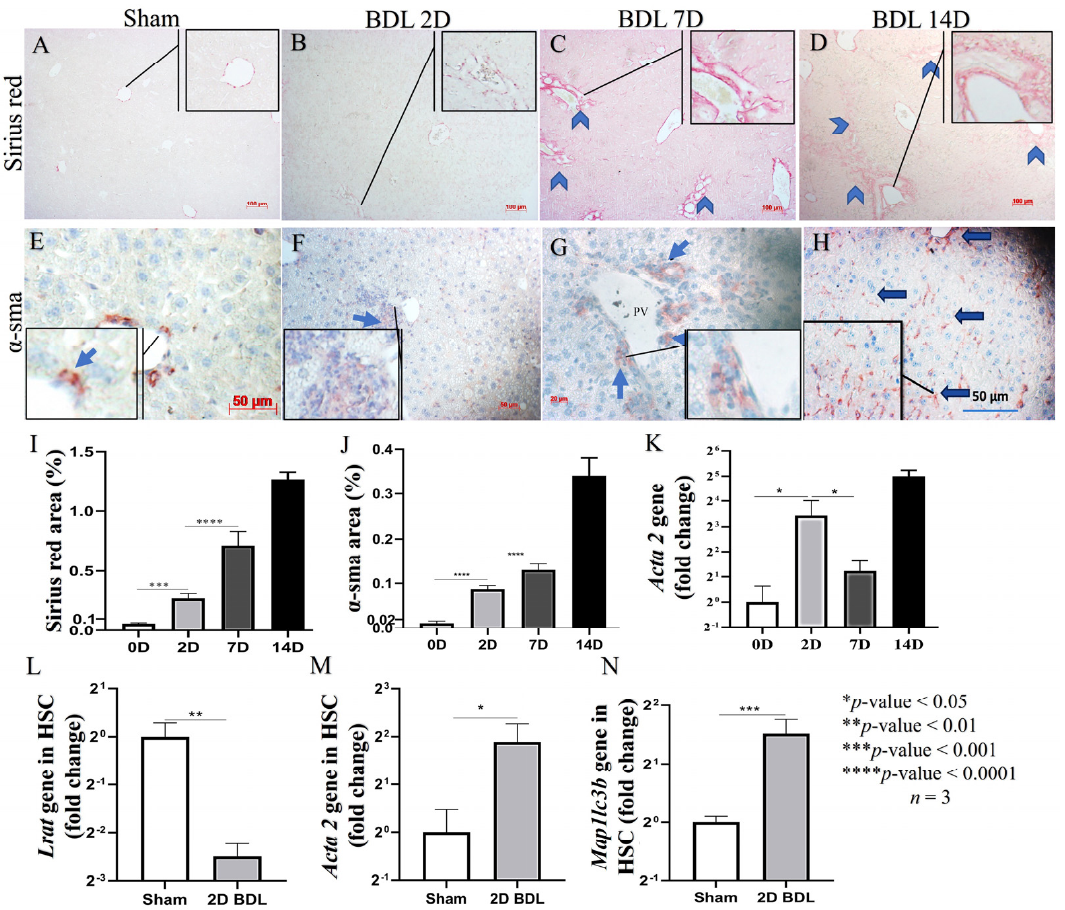
Figure 2. Hepatic stellate cell activation following bile duct ligation. ( A ) Sirius red staining of liver tissues in control animal. ( B – D ) Sirius red staining of liver tissues in BDL animals over time; head arrows indicate portal fibrosis. ( E ) α -sma staining of liver tissue in control animal. ( F – H ) α -sma staining of liver tissue in BDL animals over time; blue arrows indicate interstitial HSC and portal MBF positive for α -sma. ( I ) Quantification of Sirius red staining of liver tissues in BDL animals over time. ( J ) Quantification of α -sma in liver tissues in BDL animals over time. ( K ) Quantification of acta 2 mRNA level in liver tissues of BDL animals over time. ( L – N ) mRNA levels of lrat ( L ), acta 2 (M) and Map1lc3b ( N ) in HSC isolated from Sham and BDL mice. * p < 0.05, ** p < 0.01, *** p < 0.001, **** p < 0.0001, n = 3, scale bar: 100 µ m for sirius red and 50 µ m for α -sma